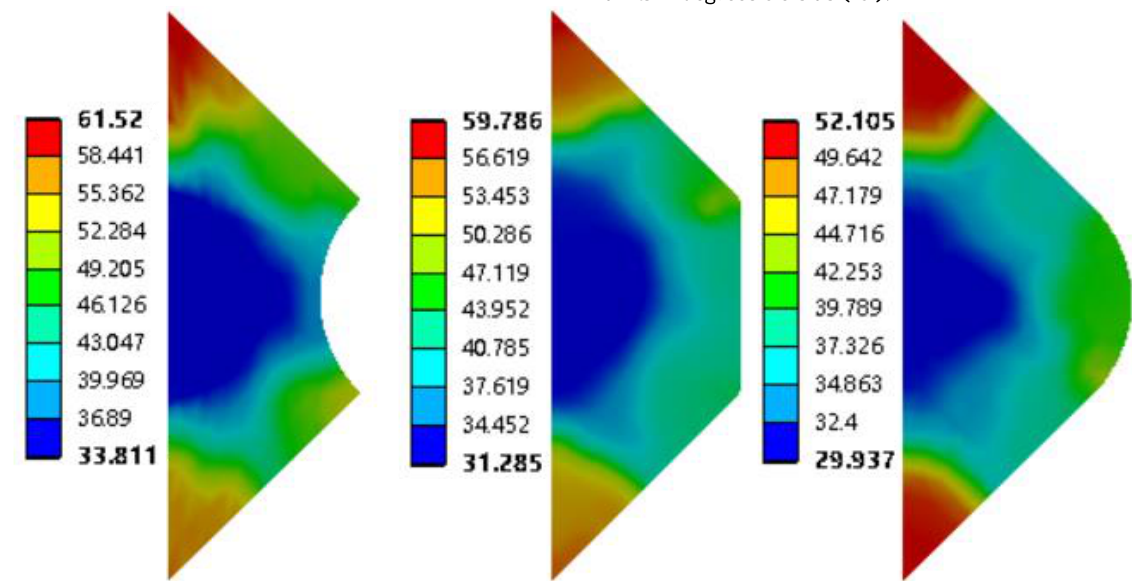
FIGURE 10. Cross-sectional view of temperature distribution at the end of the rail for different